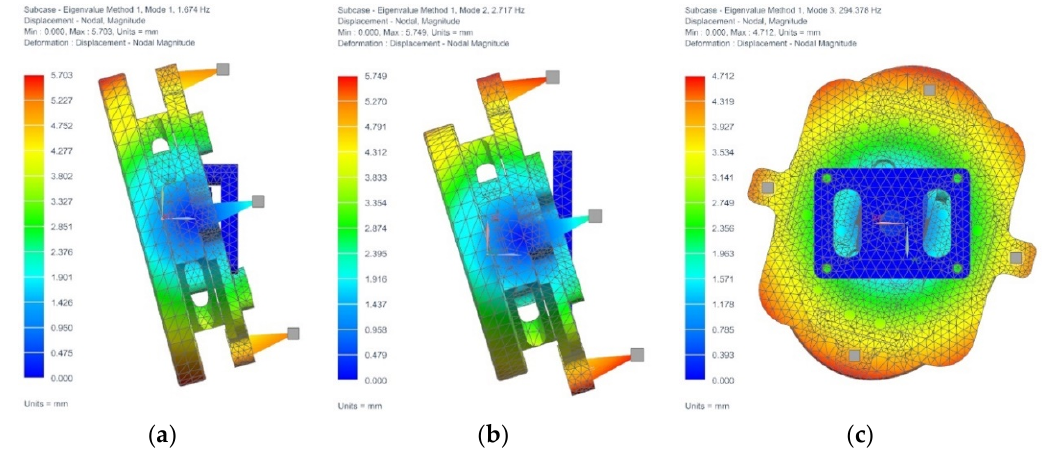
Figure 13. Modal analysis results; ( a ) First-order mode; ( b ) Second-order mode; ( c ) Third-order mode.